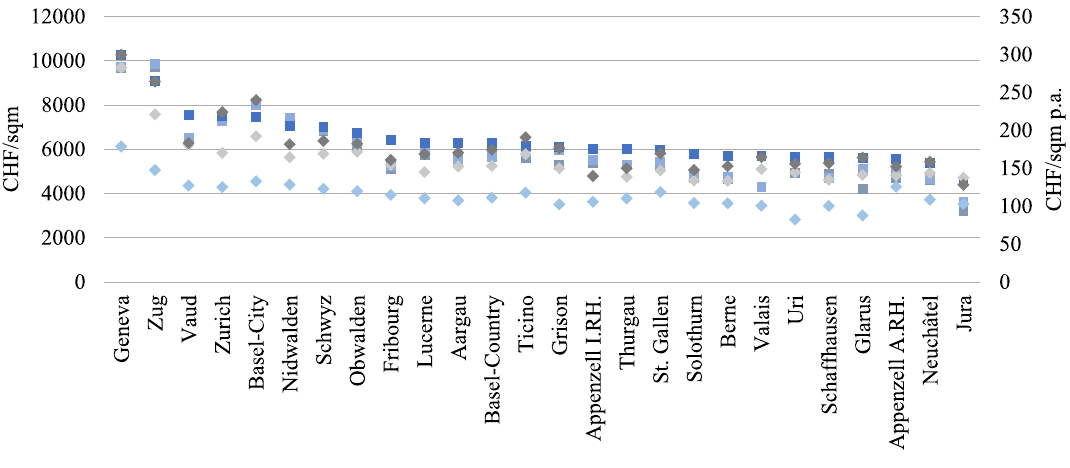
Fig. 7 Real estate prices (2018 Q4) across Swiss Cantons. Notes : Average median real estate prices in 2018 Q4 for six different real estate segments within 26 Swiss cantons. The left axis indicates the prices of houses and owner-occupied flats (CHF/sqm) and the right axis refers to rental prices per square meter and year (CHF/sqm p.a.). Source : Wüest Partner